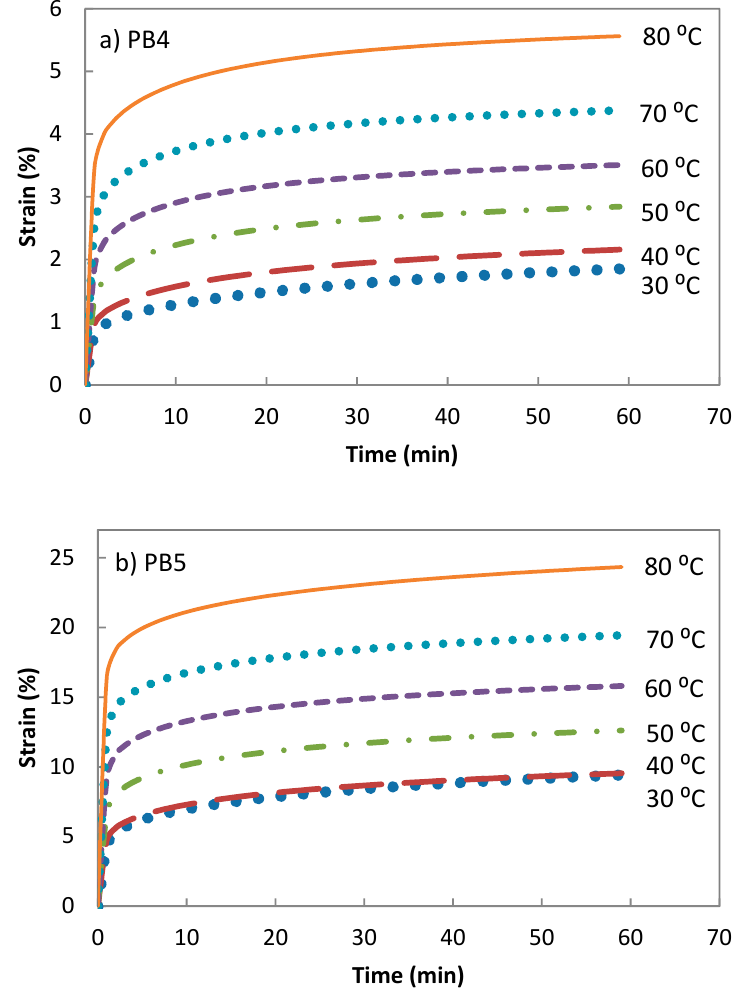
Figure 5. Creep response of ( a ) PB4; and ( b ) PB5 at an applied stress of 1.2 MPa.